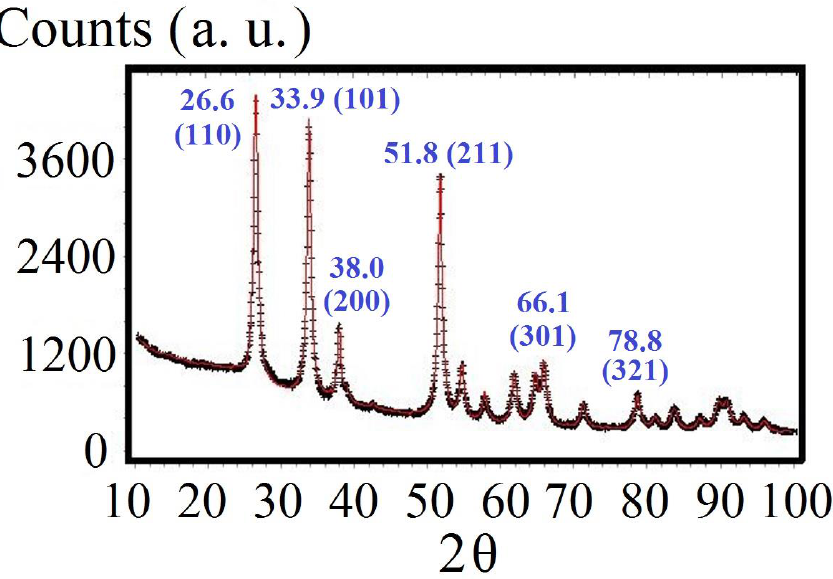
Figure 4. XRD Spectrum of the SnO 2 samples (doped with 1.4% of Cd) that were produced by using the sol–gel method. The index of the most intense peaks are given. Table 1. Lattice parameters obtained from the XRD technique for pure SnO 2 samples [21] or doped with Cd by using the sol–gel method.